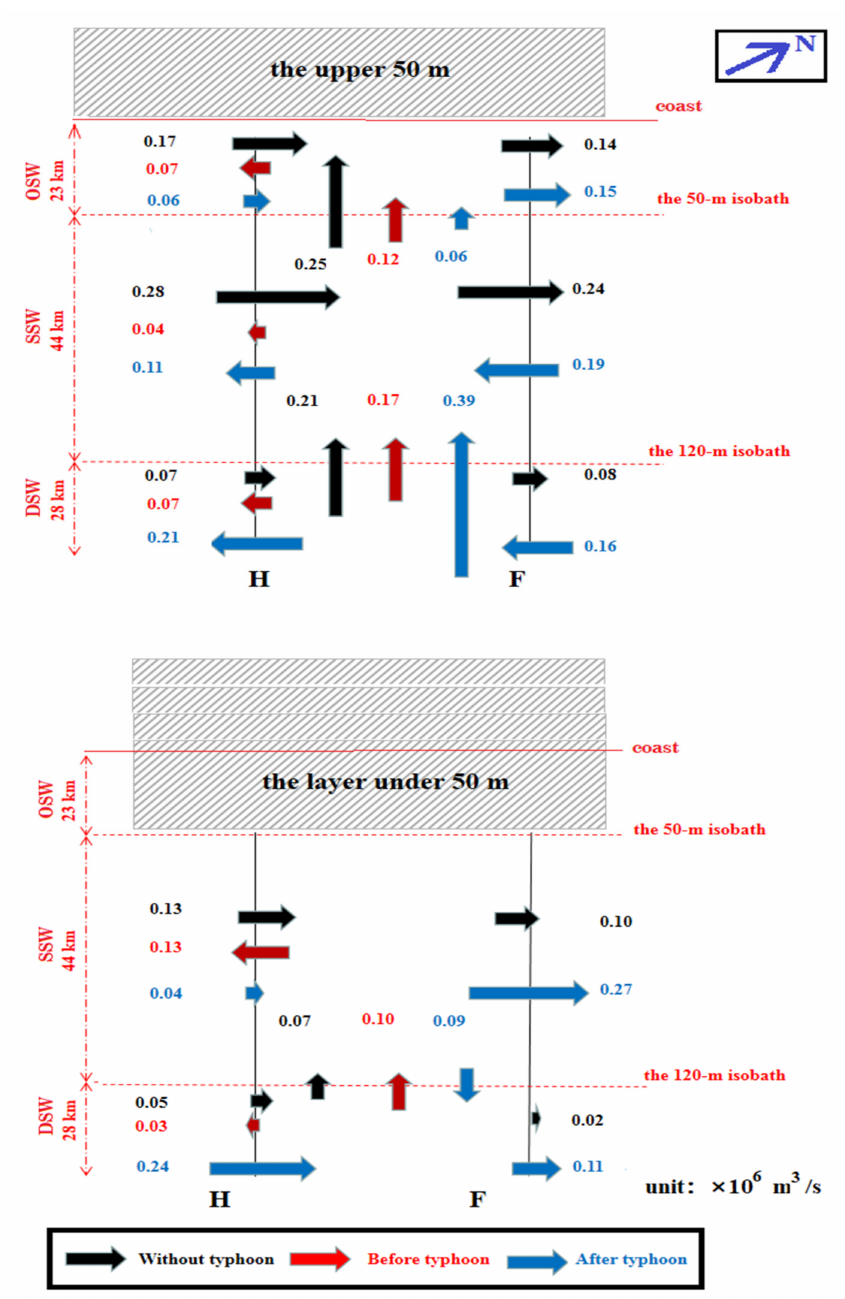
Figure 9. Diagram of volume